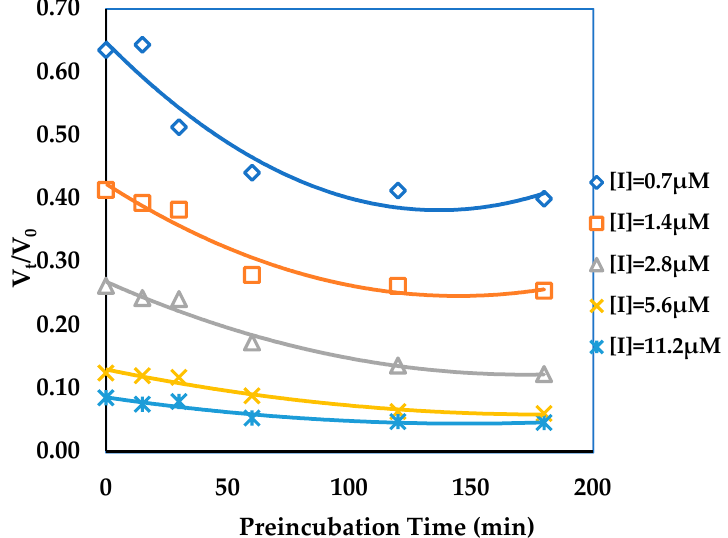
Figure 2. Effect of preincubation time with the Epicatechin gallate (ECG) on the steady state velocity of AGH enzymatic reaction. The pNPG concentration was 1.44 mM, and the ECG concentrations were 0.7, 1.4, 2.8, 5.6, 11.2 µM. The preincubation time dependence of reaction velocity showed that ECG was a slow binding inhibitor against AGH.